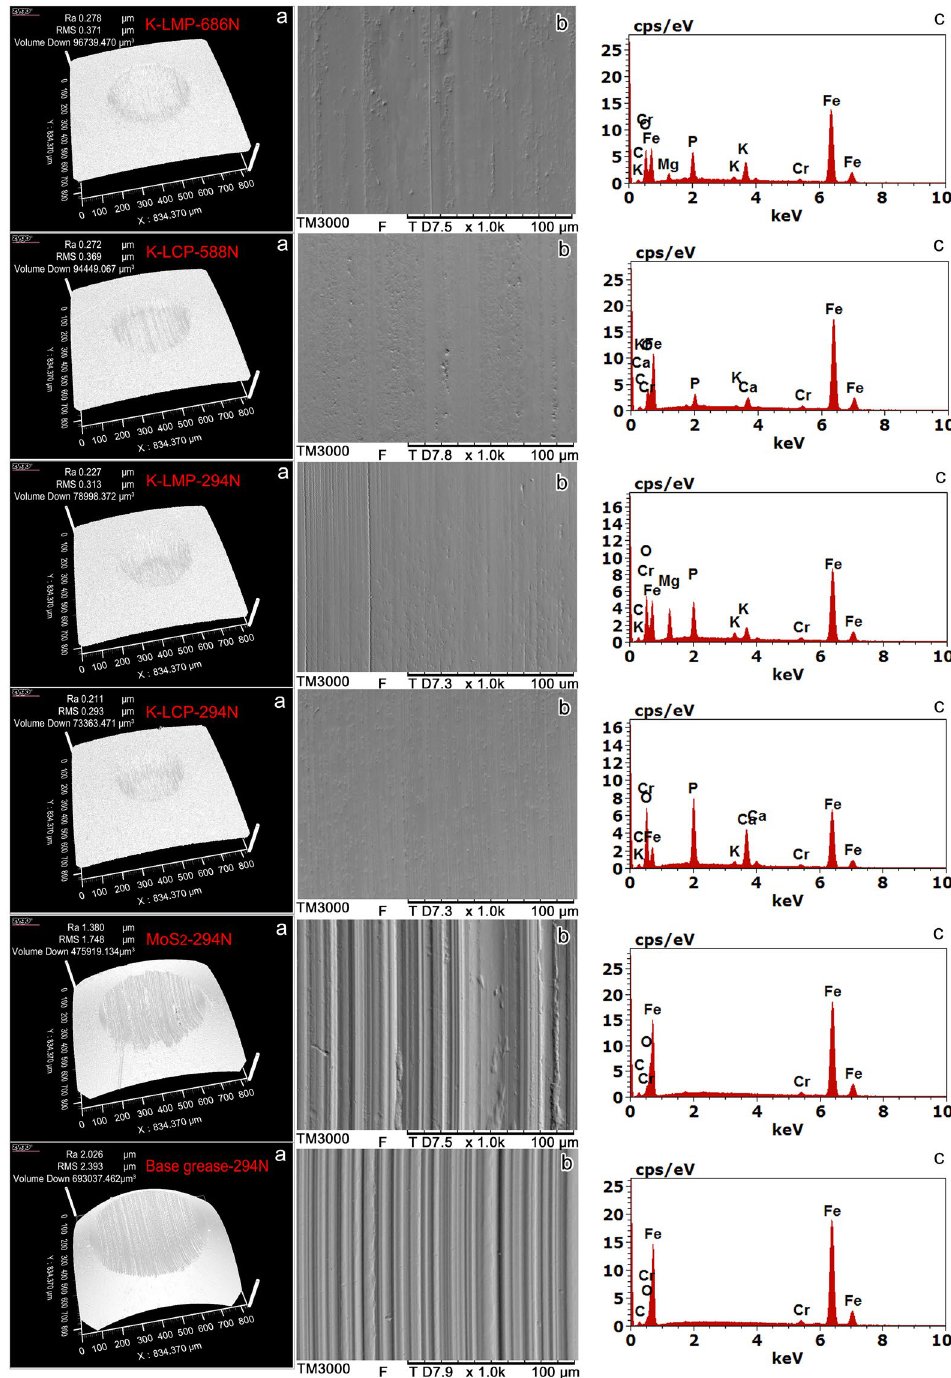
Figure 7. Analysis of the rubbing surface after long run (3600 s) friction-wear testing. ( a ) Non-contact 3D. ( b ) SEM. ( c ) EDS. Details of friction-wear test conditions are as follows: coconut oil calcium-based grease; 75 °C, 1200 rpm, 3600 s. The layered phosphates clearly formed protective films on friction pairs during the friction- wear